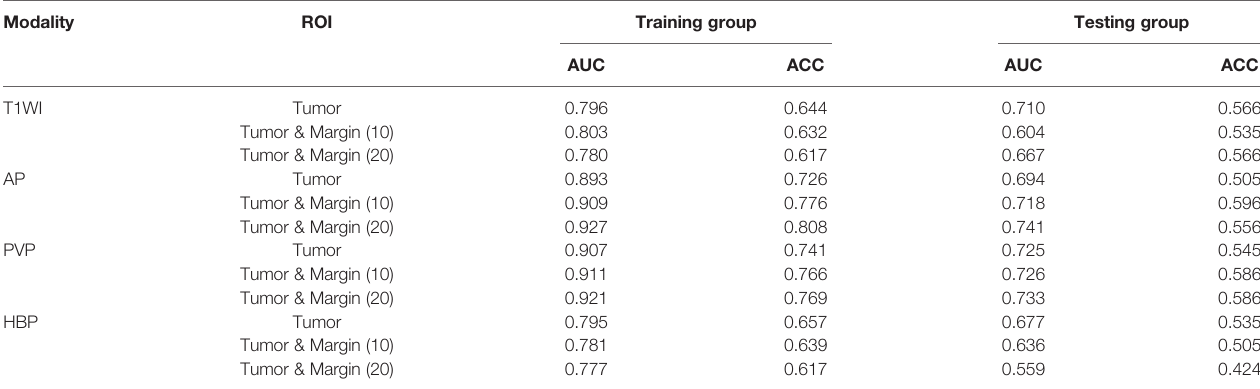
TABLE 3 | Unimodal radiomics models based on different